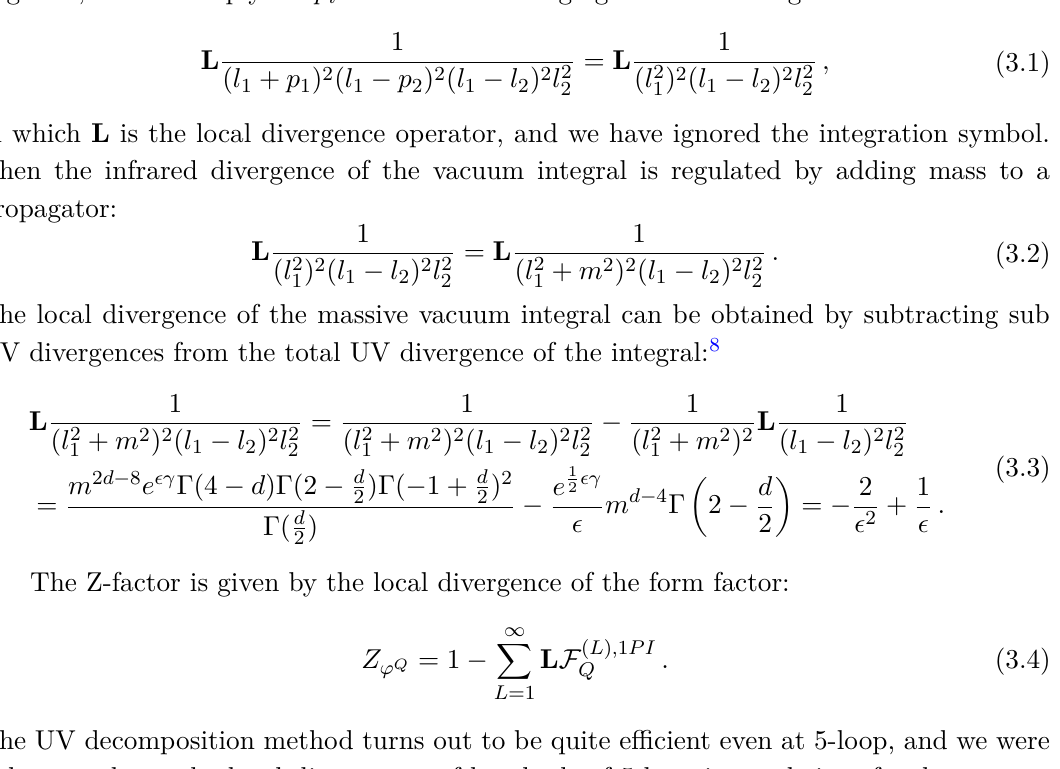
Figure 7 . An integral which contributes to F (2) of the